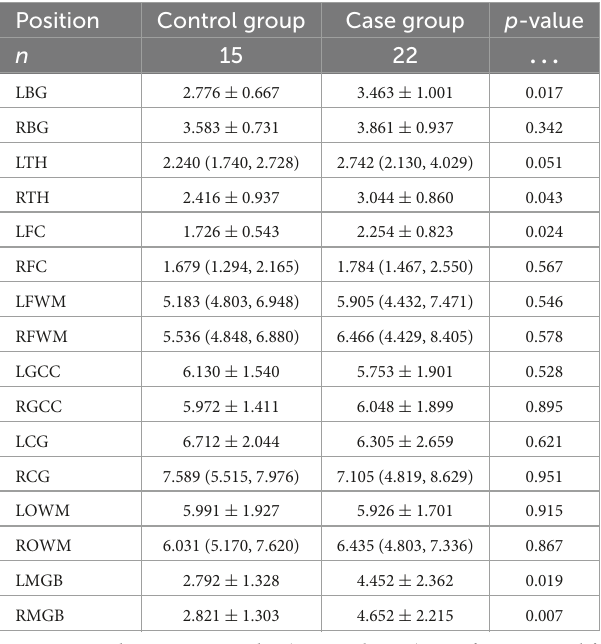
TABLE 4 Glutamate chemical exchange saturation transfer (Glu-CEST)% values for each ROI of the case group and the control group.